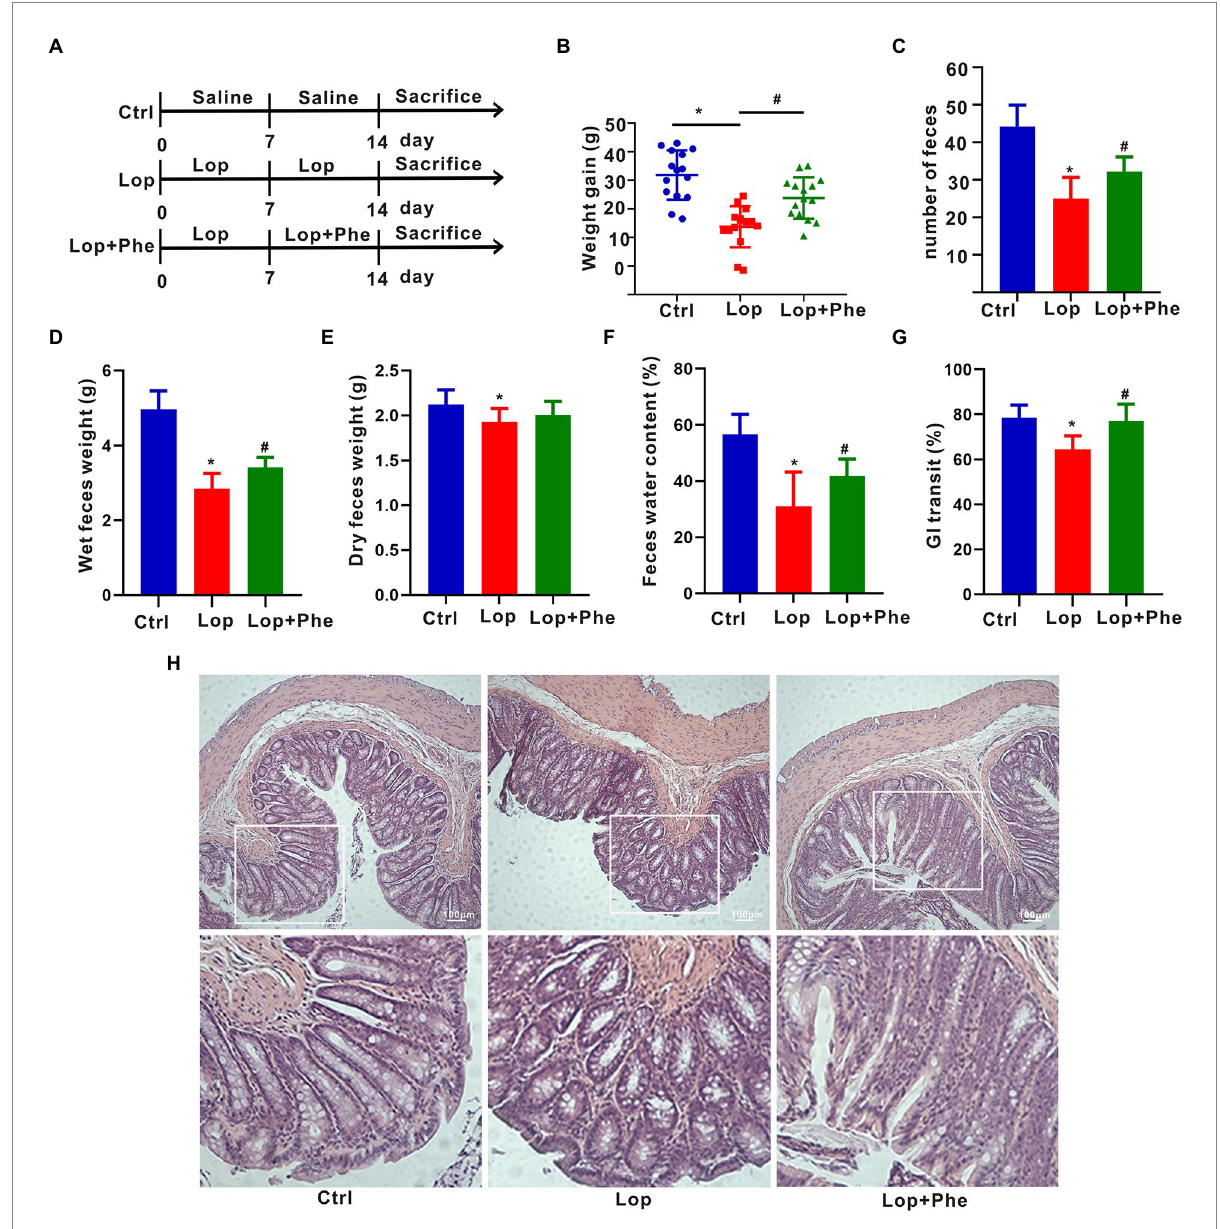
FIGURE 1 Effects of Phe on defecation-related parameters and colonic tissue injury in constipated rats. (A) Experimental process. (B) Weight gain ( n = 15). (C) Number of feces ( n = 5). (D) Weight of wet feces ( n = 5). (E) Weight of dry feces ( n = 5). (F) Fecal water content ( n = 5). (G) Gastrointestinal transit rate ( n = 3). (H) Colonic staining using hematoxylin and eosin ( n = 3). * p < 0.05 compared to Ctrl group; # p < 0.05 compared to LOP